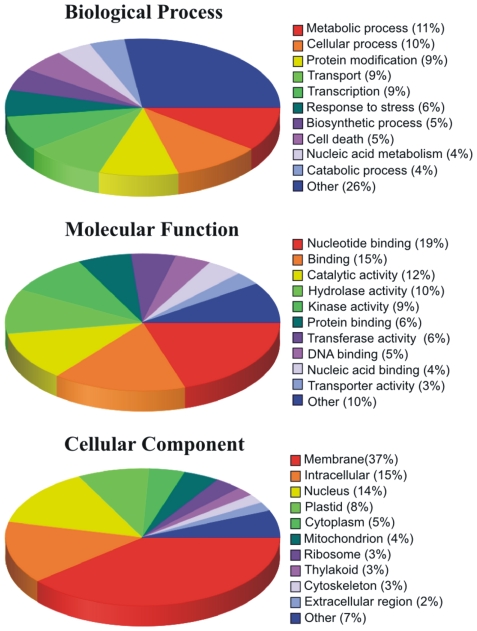
Percentage distribution of the GO entries associated wheat 454 reads for chromosome 5A.The most represented entries within the three ontologies (Molecular function, Biological process and Cellular component) are indicated.